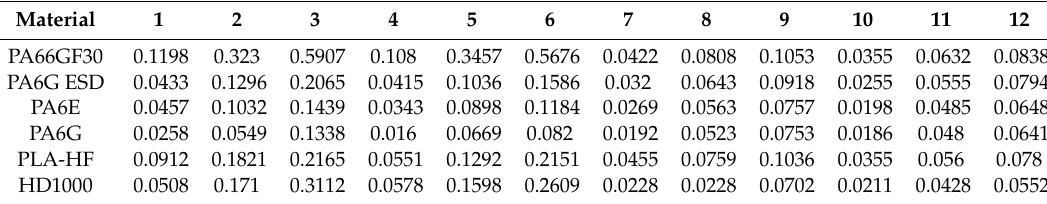
Table 4. The slope values (speed of wear) of linear regression in all the 12 test conditions.